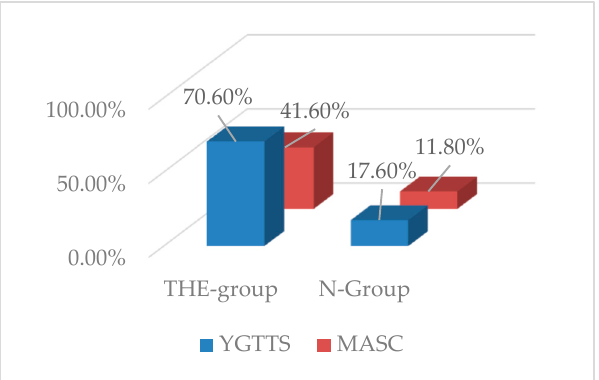
Figure 2. Patients who achieved a clinical response from baseline (T0) at T1.